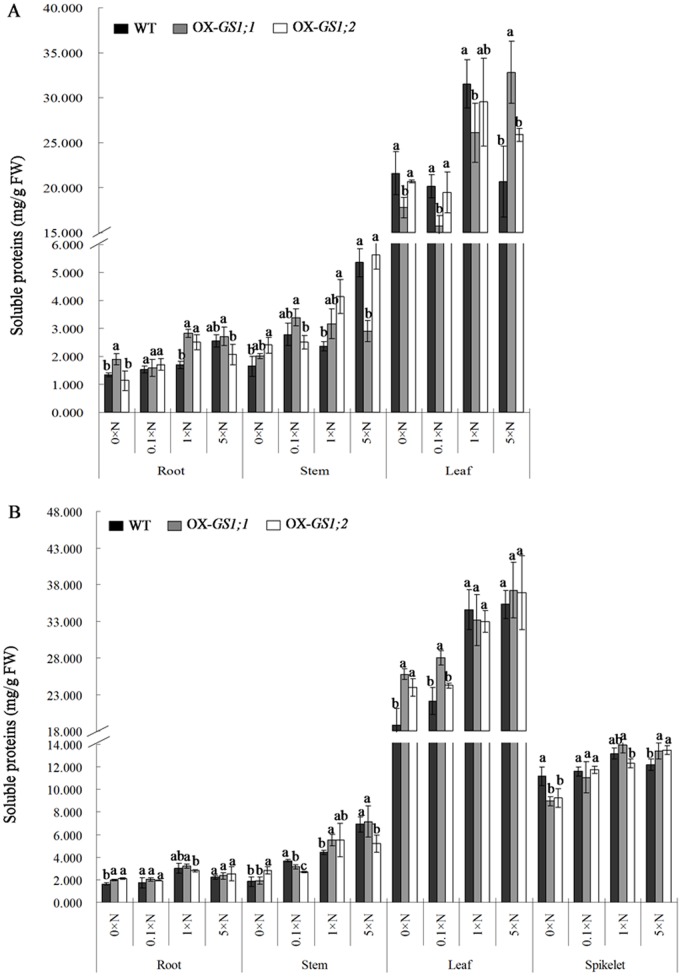
The concentration of soluble proteins in the roots, stems and leaves of the GS1;1-, GS1;2-overexpressing plants (OX-GS1;1, OX-GS1;2) and wildtype plants (WT) at the tillering stage (A) and the heading stage (B) under 0×N, 0.1×N, 1×N and 5×N conditions.Values are the mean ± SD from three biological replications using three randomly mixed plant materials. a, b, c indicate the significant difference at the level of P = 0.05.